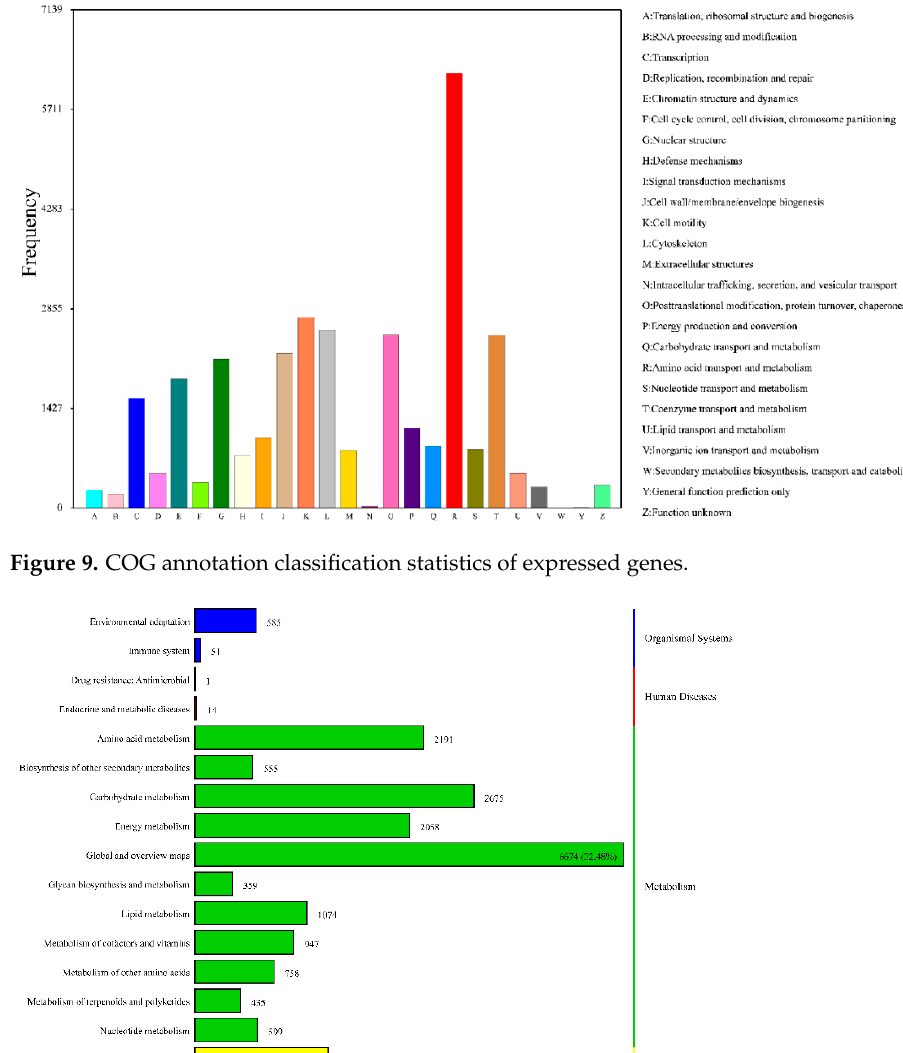
Figure 8. GO function classification .